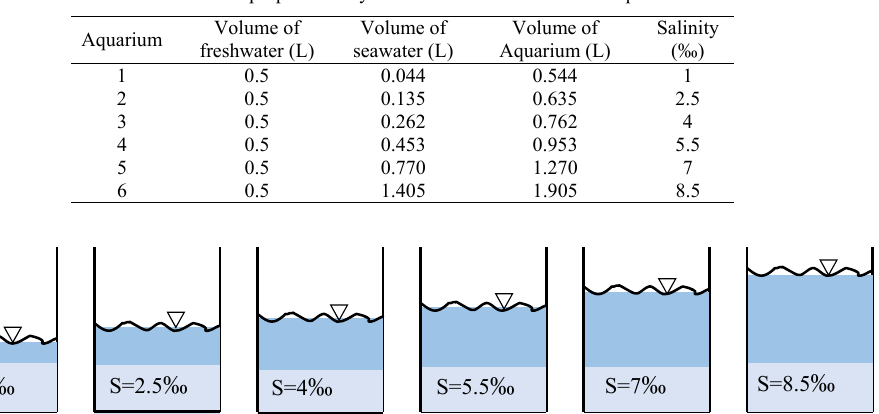
Fig. 2: A diagram showing the mixture of freshwater and saline water